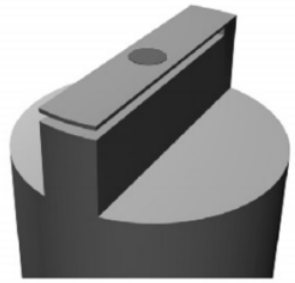
Figure 7. 3D model of the glass ferrule-top cantilever [65].